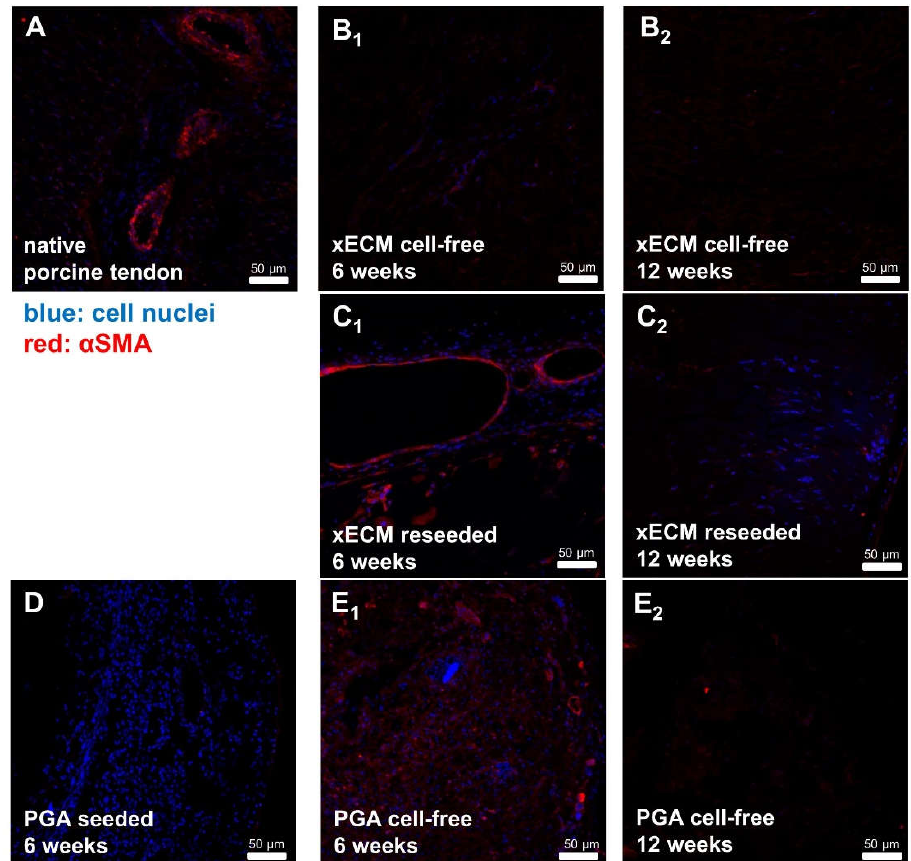
Figure 7. αSMA expression in native and recellularized xECM in vivo six and 12 weeks after implantation in the nude mice. ( A ) Native porcine AS tendon, ( B , C ) xECM decellularized and implanted in nude mice for six ( B 1 ) and 12 weeks ( B 2 ) or xECM recellularized with human tenocytes and implanted in nude mice for six ( C 1 ) and 12 weeks ( C 2 ), immunolabeled for αSMA using a Cy3-coupled secondary antibody. ( D ) PGA, recellularized and implanted for six weeks. ( E ) PGA, implanted cell-free for six ( E 1 ) and 12 ( E 2 ) weeks (w) in vivo. 2.8. Detection of Human Cell Nuclei in Recellularized xECM and Implanted in Nude Mice for Six and 12 Weeks